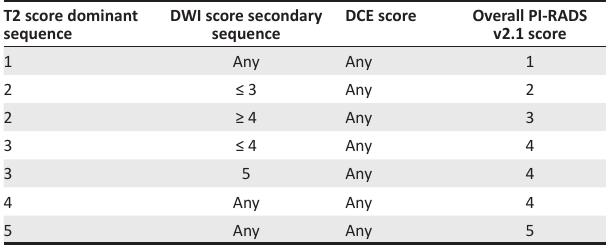
TABLE 6: Combined scoring system to evaluate a TZ